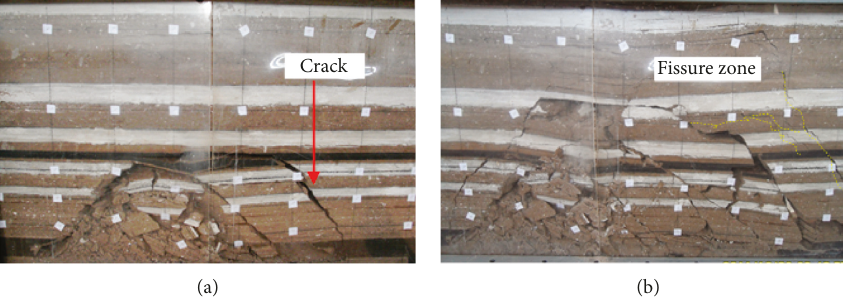
Figure 5: Some typical roof collapse of mining caving in coal with a thickness of 15m. (a) 188m; (b)